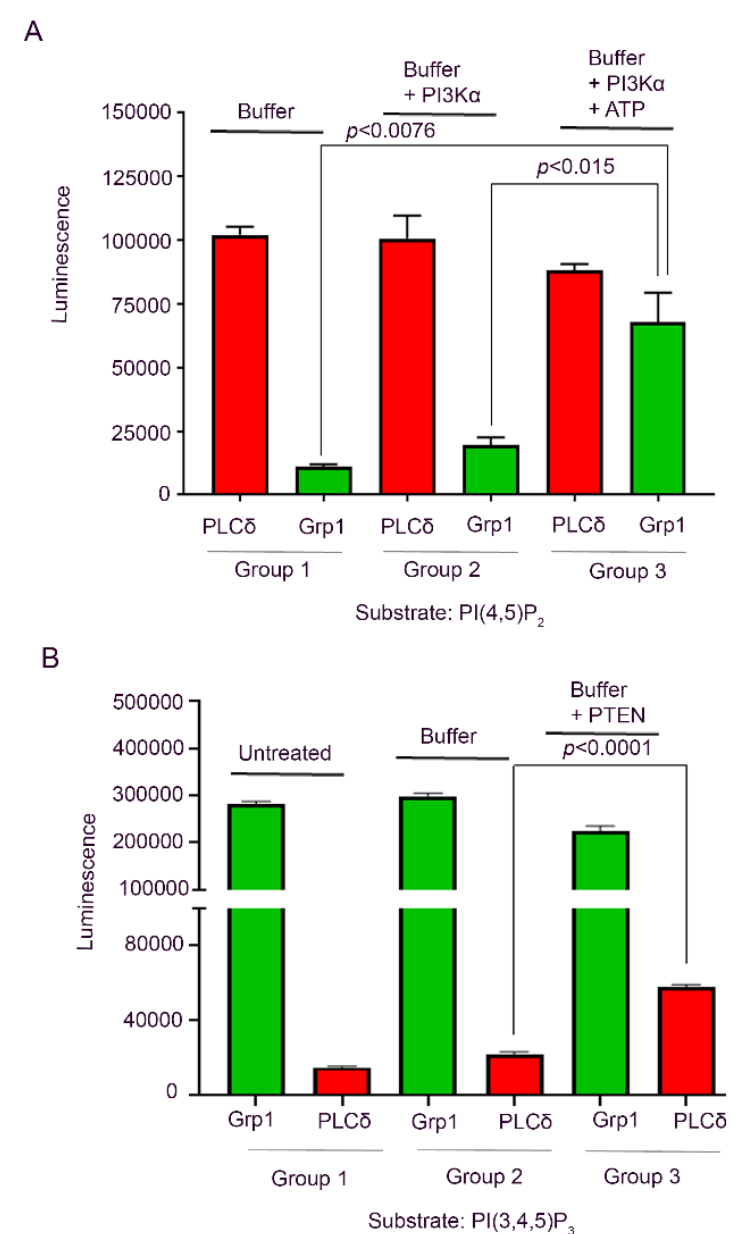
Figure 6. Recombinant PI kinase and PI phosphatase ELISA. For PI kinase assay, 5 pmol PI(4,5)P 2 in PC/PE/PS solution was loaded into a 96-well ELISA plate and divided into three groups. Group 1 is treated with only kinase buffer; group 2 with kinase buffer and PI3K α ; and group 3 with kinase buffer, PI3K α , and ATP ( A ), and carried out phosphorylation and PI assay as described in the methods. In each group, PI(4,5)P 2 and PI(3,4,5)P 3 were detected using the PH domains of PLC δ and Grp1, respectively. For PI phosphatase, PTEN 5 pmol PI(3,4,5)P 3 was plated on a 96-well ELISA plate and divided into three groups. Group 1 is untreated, group 2 with only reaction buffer, and group 3 with reaction buffer and PTEN ( B ). The phosphatase treatment and the PI assay was carried out as described in the methods. In each group, PI(3,4,5)P 3 and PI(4,5)P 2 and were detected using the PH domains of Grp1 and PLC δ , respectively. Data are mean ± SEM, ( n = 3). Significance is indicated in